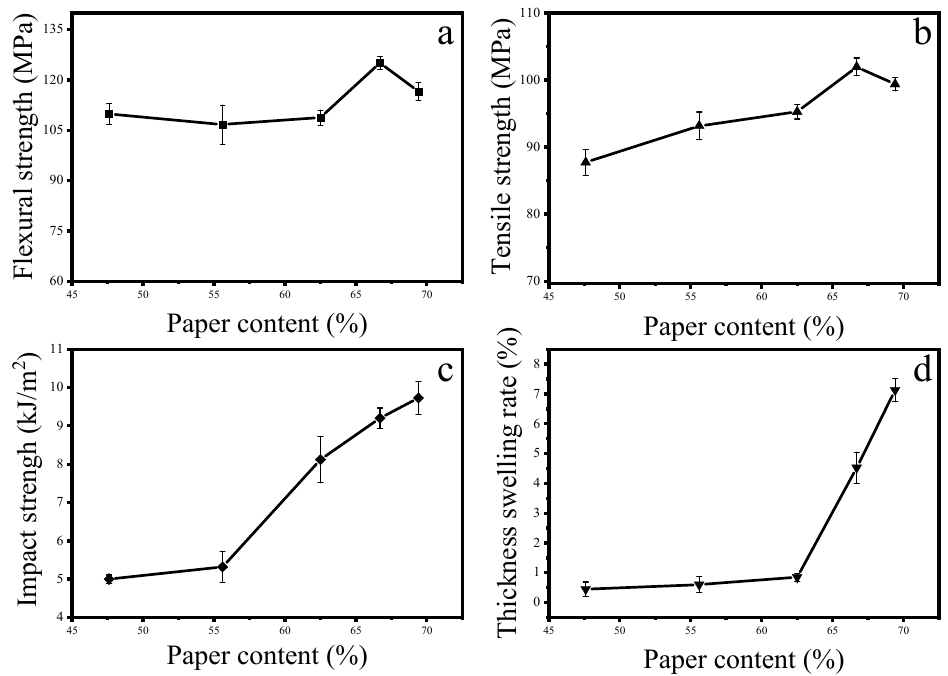
Figure 3. Effect of paper content on the properties of composites: ( a ) flexural strength; ( b ) tensile strength; ( c ) impact strength; ( d ) thickness swelling rate.